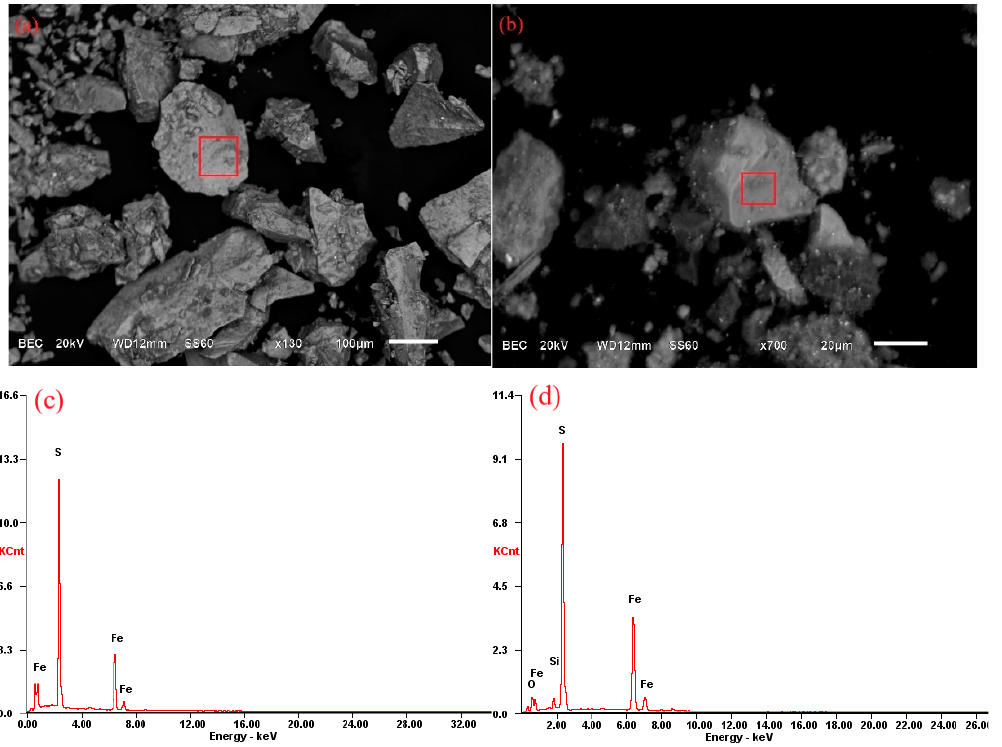
Figure 7. SEM micrographs and EDS analysis of ( a ) silver-bearing pyrite, ( b ) pyrite in the leaching residual of bioleaching test (No. 9), ( c ) spectrum analysis of selected area in ( a , d ) spectrum analysis of selected area in ( b ). Table 9. Element content of selected area in (a) and (b).